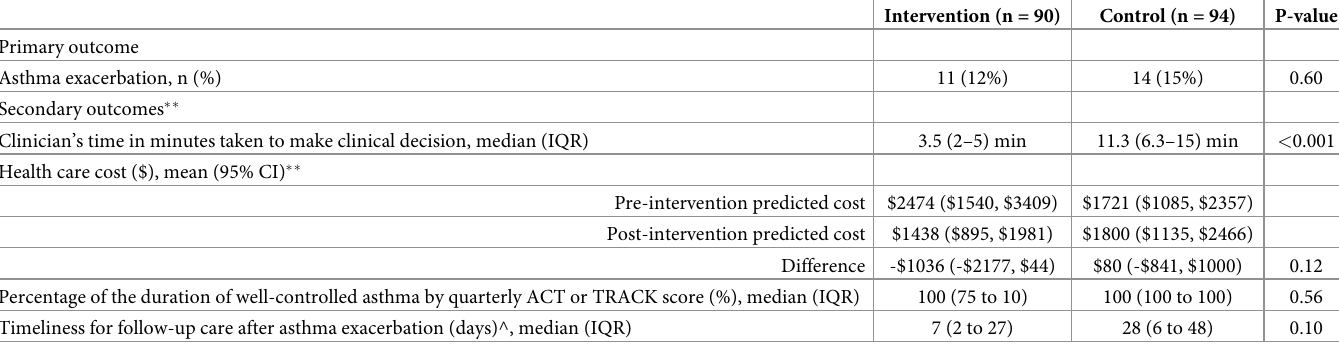
Table 2. Primary and secondary outcomes in intervention and control